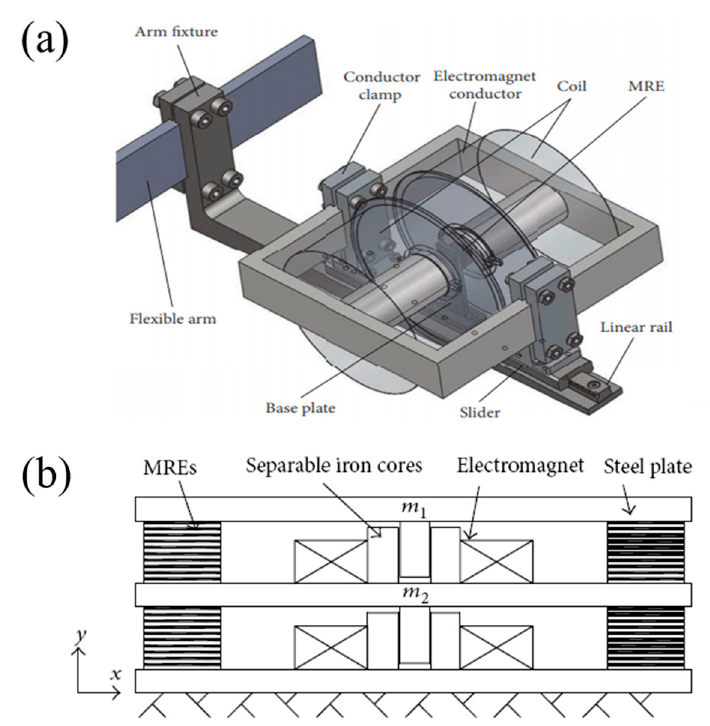
Figure 10. Schematic diagram of ( a ) MRE vibration absorber (Reprinted with permission from [145] and ( b ) MRE isolation system [146].